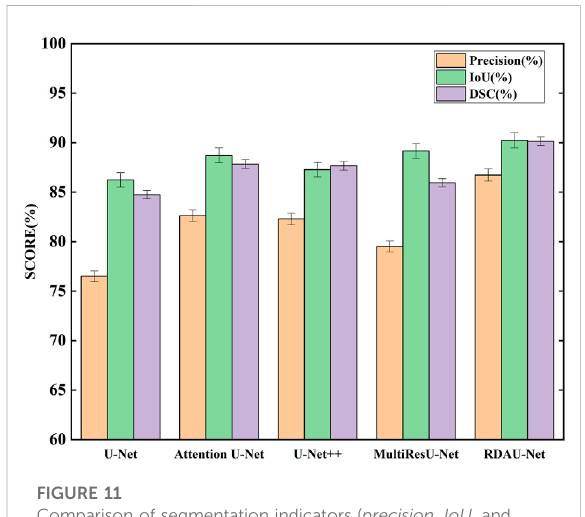
FIGURE 11 Comparison of segmentation indicators ( precision , IoU , and DSC ) of fi ve models. Among the fi ve models, RDAU-Net can achieve the best segmentation indicators.